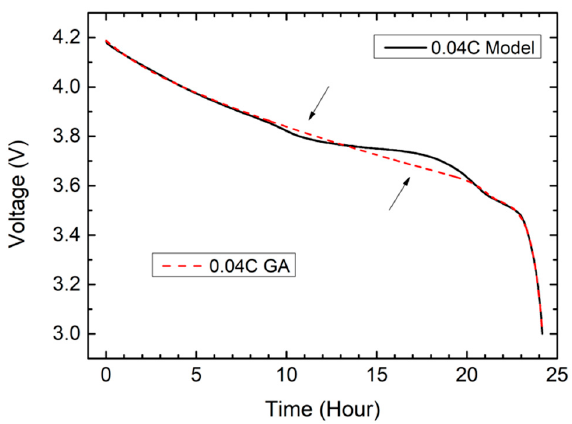
Figure 24. GA results 2 (S brand 18650).